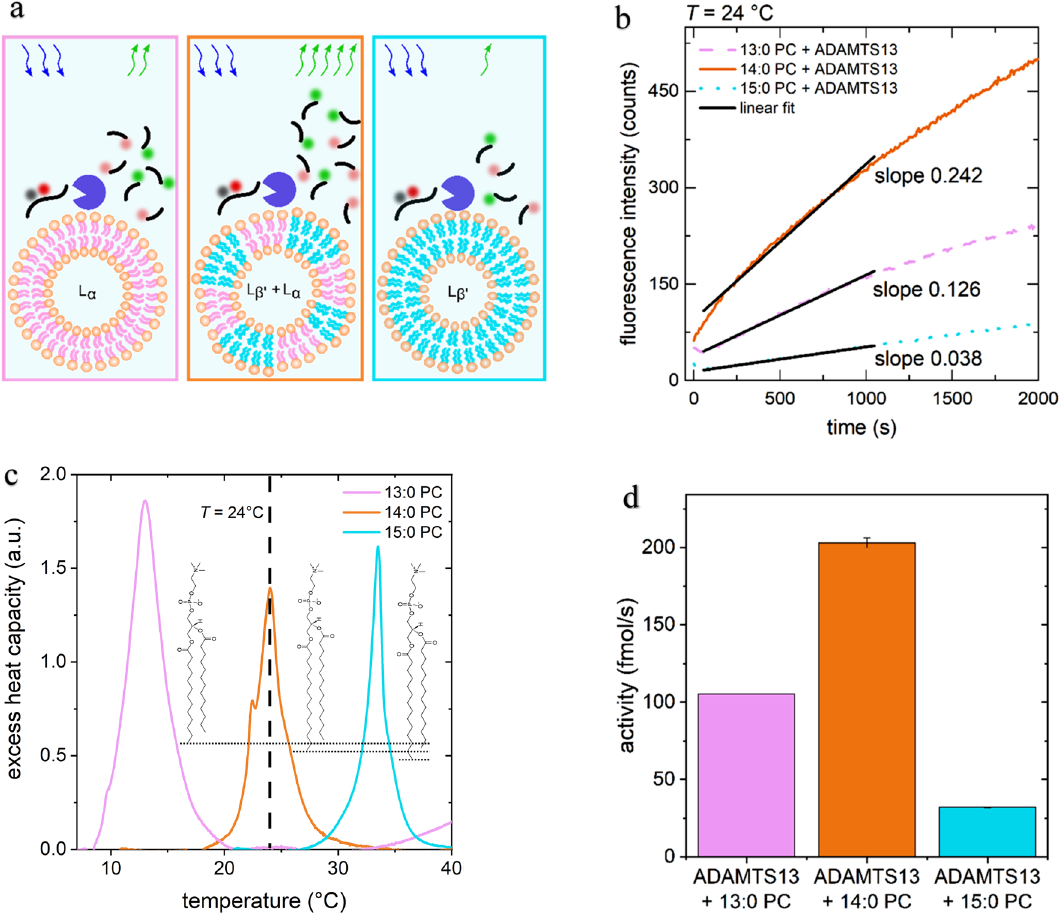
Figure 2. ( a ) Illustration of the experimental setup: ADAMTS13 (purple circle segment) was attached to three different liposomes: 13:0 PC (left), 15:0 PC (right), and 14:0 PC (middle), FRET-substrate was added (black with colored dots). At 24 °C, the phase states of the liposomes are respectively L α , L β’ , and in coexistence, respectively, as illustrated by their acyl-chain shape and color. ( b ) ADAMTS13 kinetics for the 13:0 PC, 14:0 PC, and 15:0 PC samples at T = 24 °C. The enzyme bound to 14:0 PC clearly displays the highest activity. ( c ) Excess heat capacity of LUV of three phosphocholines with different acyl-chain lengths. At 24 °C all three membranes are in a different phase state: 13:0 PC is L α , 15:0 PC is L β’ , and 14:0 PC is in the coexistence regime. ( d ) ADAMTS13 activity determined from the kinetics shown in ( b